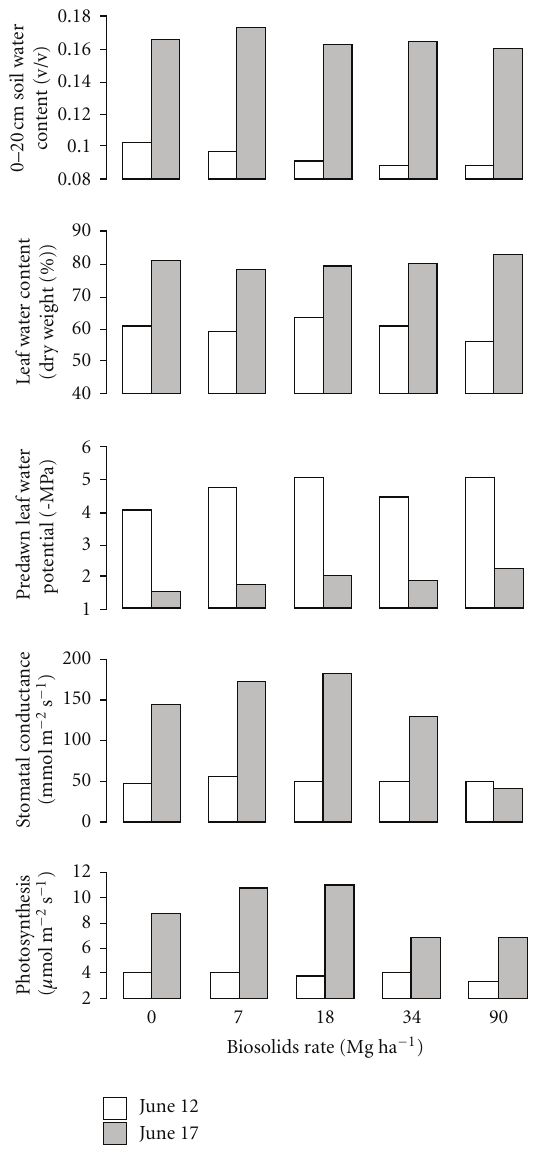
Figure 7: Photosynthesis and water relation responses on 12 June and 17 June to a 23.3mm of rainfall that occurred 14 June 1997 in Larrea tridentata as a ff ected by biosolids applications (redrawn from [12]).